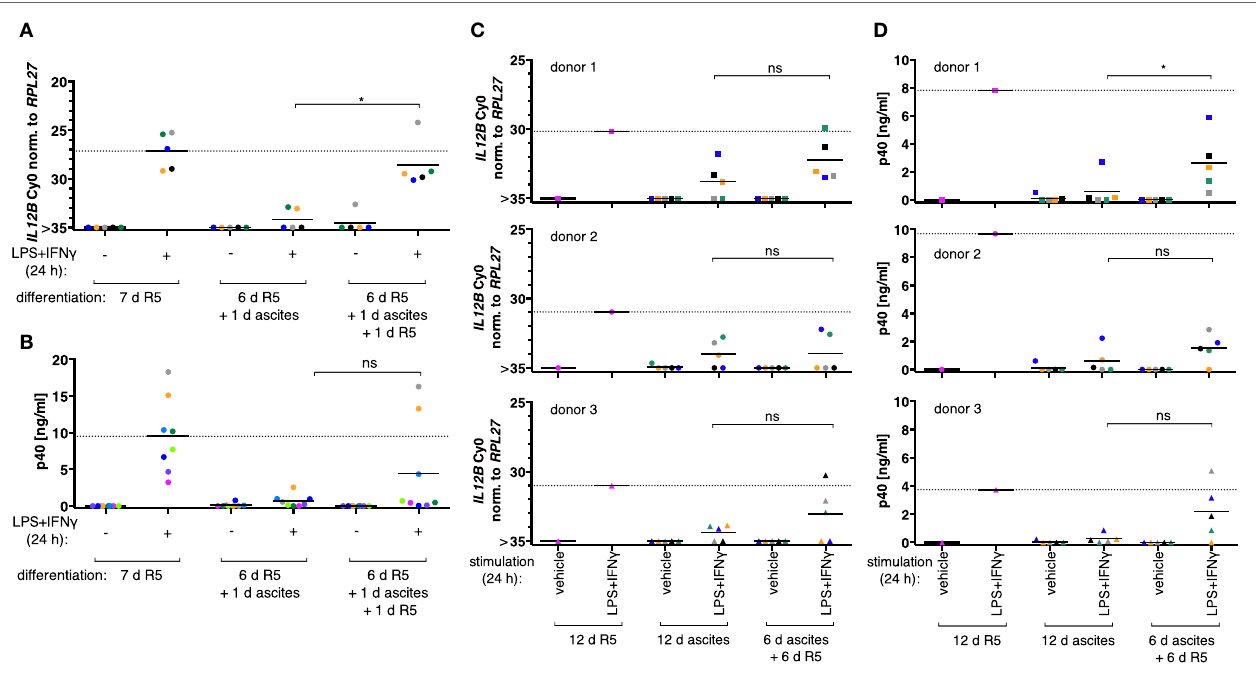
FigUre 2 | Ascites-mediated suppression of IL12B in monocyte-derived macrophages is reversible upon ascites withdrawal. IL12B expression induced by LPS and IFN γ in MDMs (differentiated as indicated) was measured by RT-qPCR (a,c) or in culture supernatants by ELISA (B,D) . Cells were stimulated for 24 h prior to harvesting, or the respective solvents (vehicle) were added, respectively. (a,B) Each dot denotes a biological replicate (healthy donor; N ≥ 5) randomly combined with different ascites samples encoded by color. (c,D) Colors encode ascites samples from five different patients; shapes encode different healthy donors ( N = 3). Median values are indicated by horizontal bars. Statistical significances were calculated with paired t -tests. * P < 0.05; ns, not